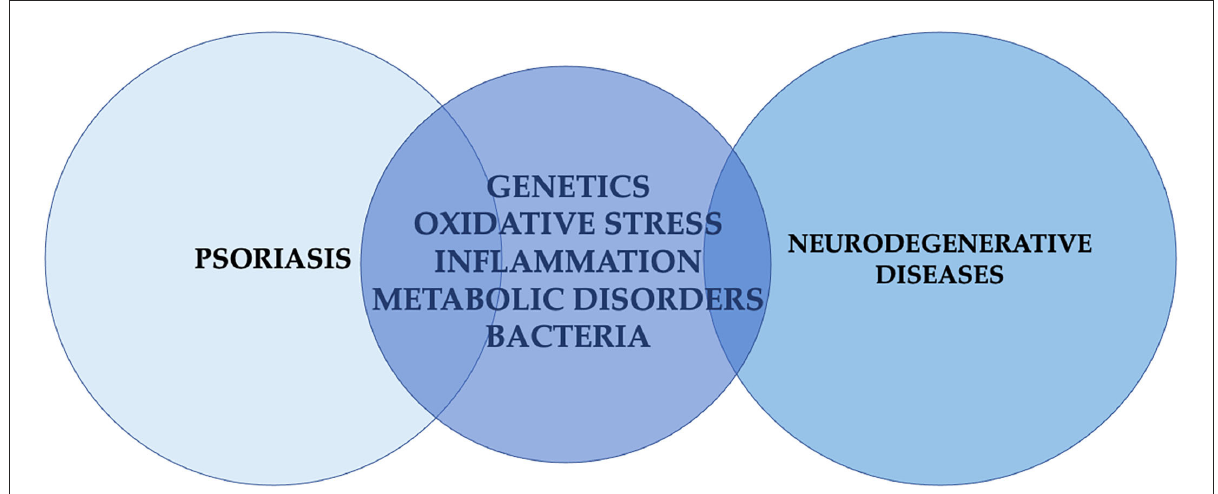
FIGURE3 Main common factors associated with psoriasis and neurodegenerative diseases.